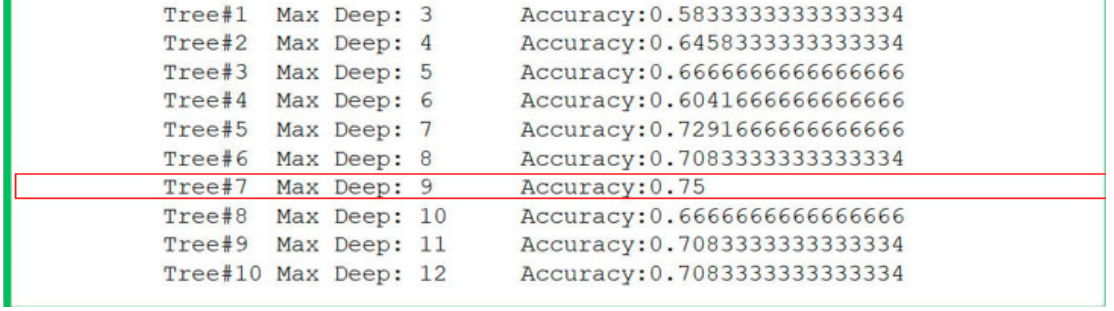
Figure 6. Calculated accuracy of decision trees created for different maximum depths from created dataset pre-processed in means of the Approach 2.